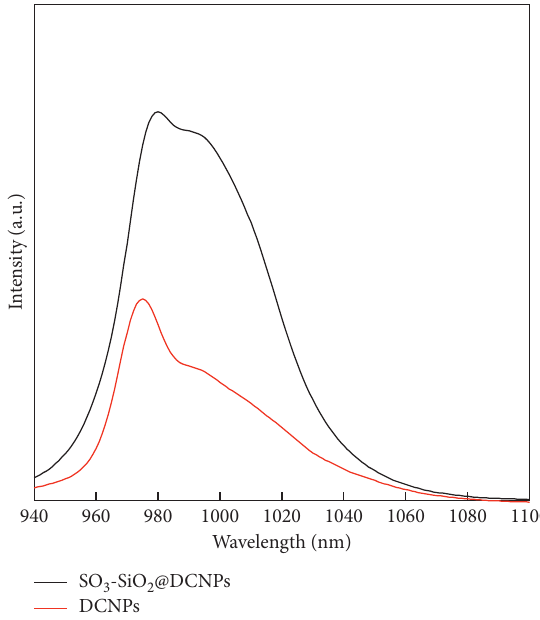
Figure 4: PL spectra of SO 3 -SiO 2 @DCNPs upon 900 nm excitation at ytterbium doping concentration of